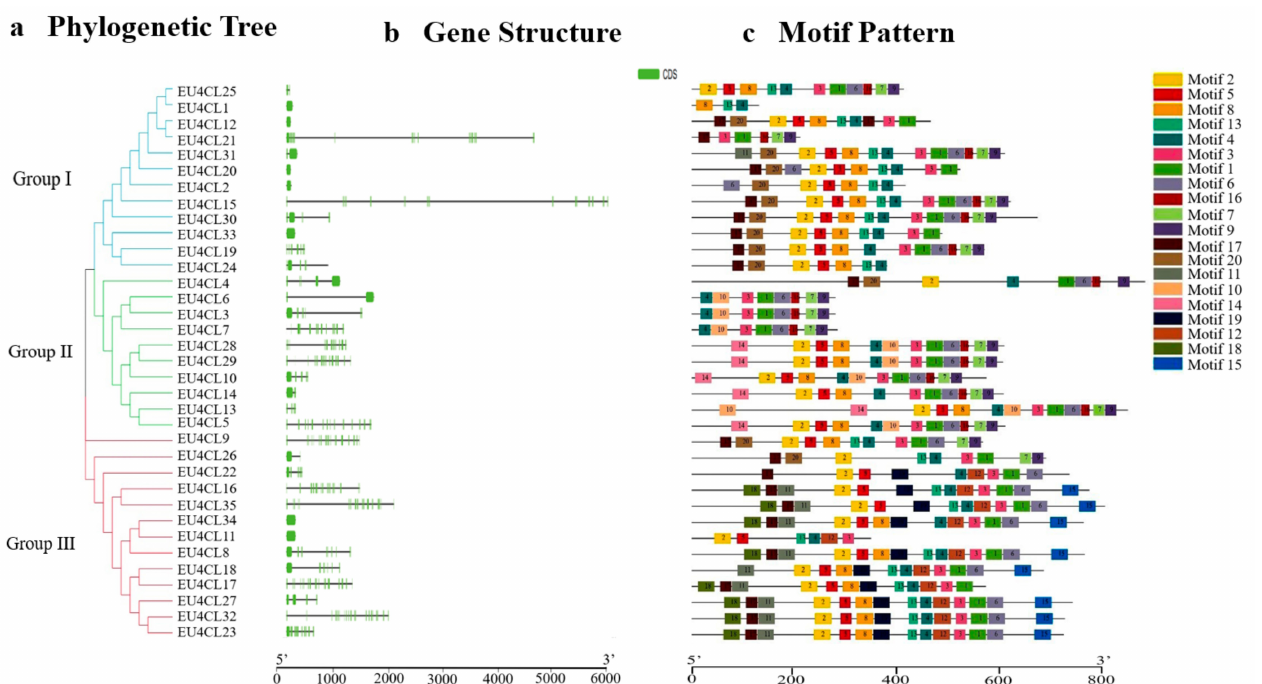
Figure 1. Phylogenetic relationships, gene structure and architecture of conserved protein motifs in 4CL genes from E. ulmoides . ( a ) The phylogenetic tree was constructed based on the full-length sequences of E. ulmoides 4CL proteins using MEGA 7 software. Details of clusters are shown in different colors. ( b ) Exon–intron structure of E. ulmoides 4CL genes, green boxes indicate exons; gray lines indicate introns. The number indicates the phases of corresponding introns. ( c ) The motif composition of E. ulmoides 4CL proteins. The motifs, numbers 1–20, are displayed in different-colored boxes. The length of protein can be estimated using the scale at the